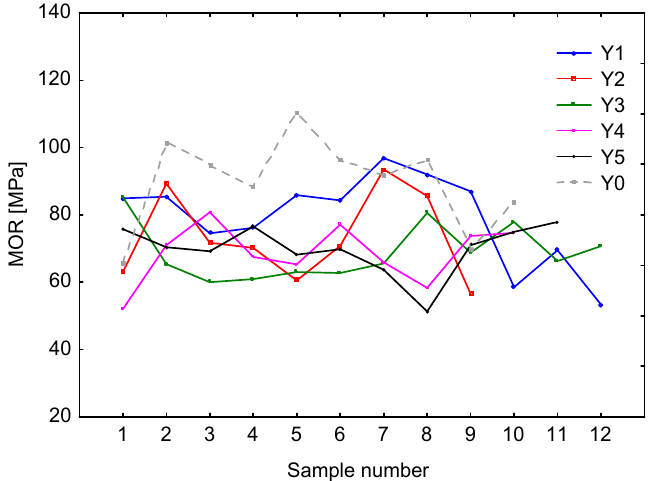
Figure 5. The radial variability for static bending resistance (MOR) of spruce wood depending on the period of time since the tree’s decay.